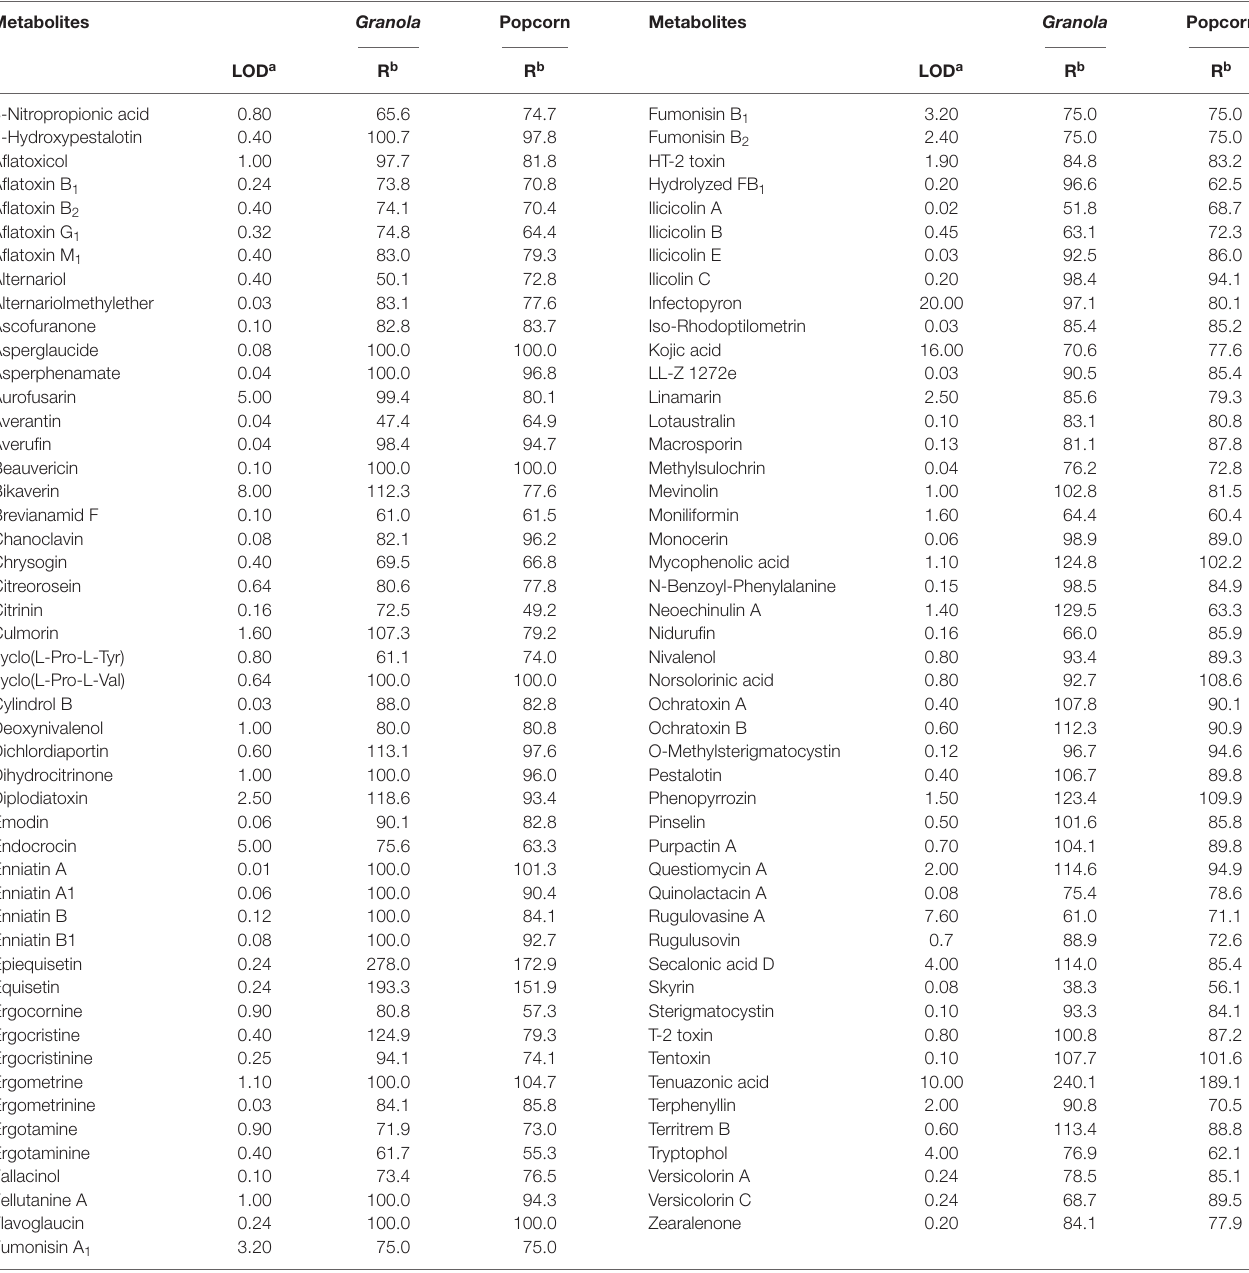
TABLE 2 | LC-MS/MS method performance characteristics for 97 metabolites in dried ready-to-eat foods in Nigeria. Metabolites Granola Popcorn Metabolites